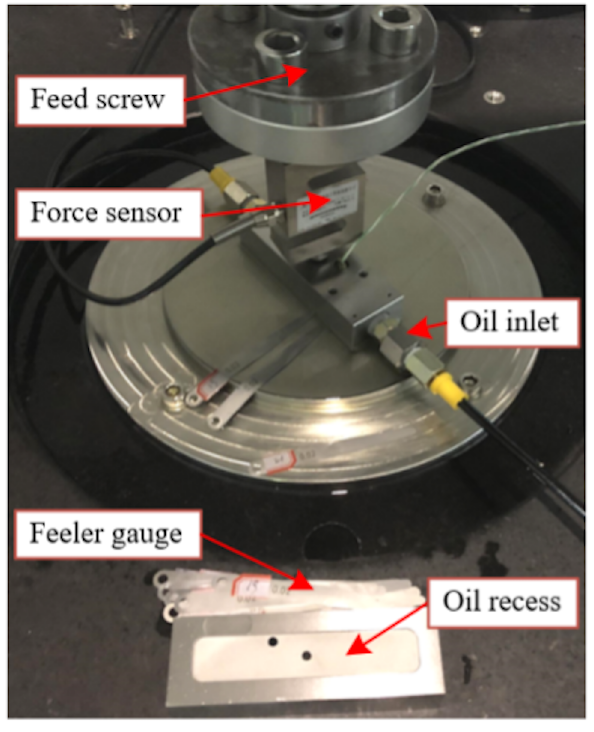
Figure 6. Experimental devices and test